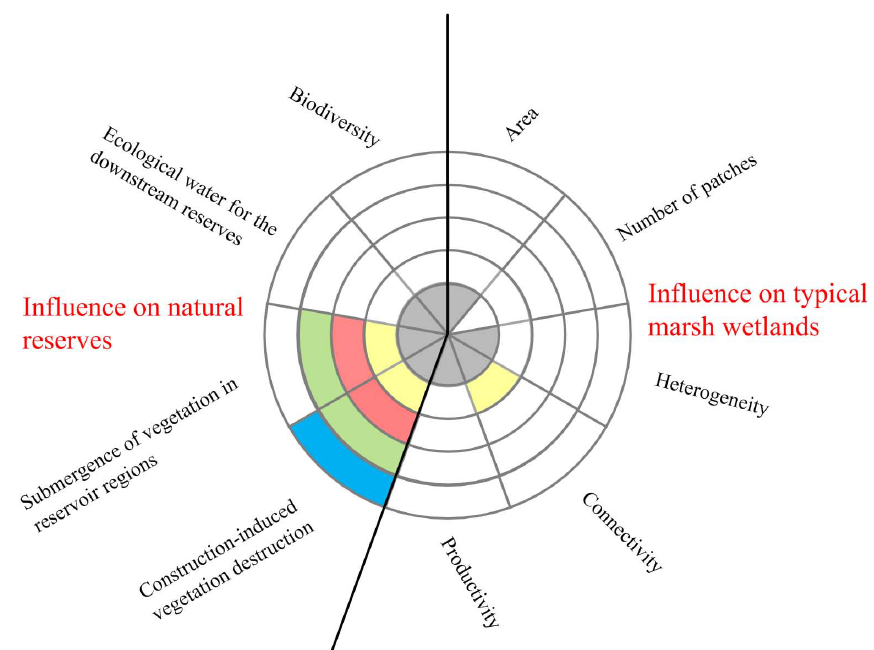
Fig. 10. Overall evaluation of the comprehensive environmental impact of the project